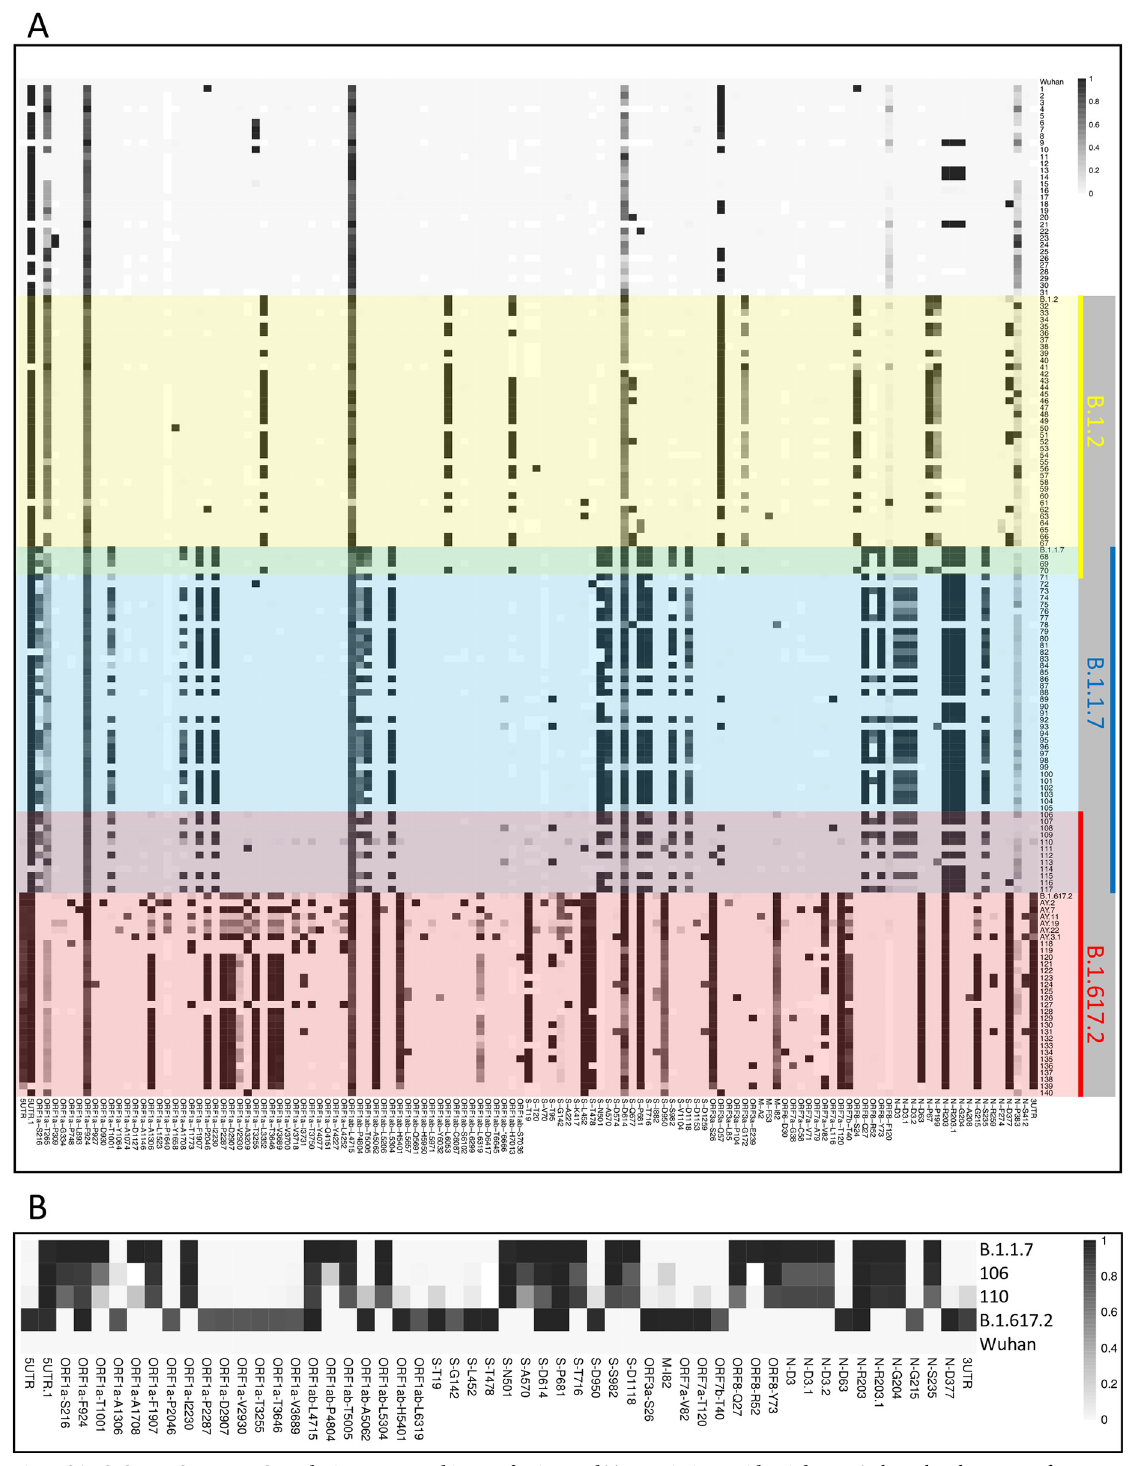
Fig 3. SARS-CoV-2 Sequence Complexity Integrated into Infection and Transmission Epidemiology. a Zebra-plot alignment of 140 sequences from the Cleveland VA study population, collected from April 2020 to August 2021 at 200 lineage defining signature positions. The grayscale bar (upper right) indicates the proportion of the alternate allele at each biallelic variant position. Integrated into the alignment of individual patient infection sequences are the Wuhan reference sequence (NC_045512.2), and aggregate plots for B.1.2 (51,069 sequences), B.1.1.7 (479,770 sequences), B.1.617.2 (258,910 sequences), AY2 (1,938 sequences), AY7 (3,443 sequences), AY11